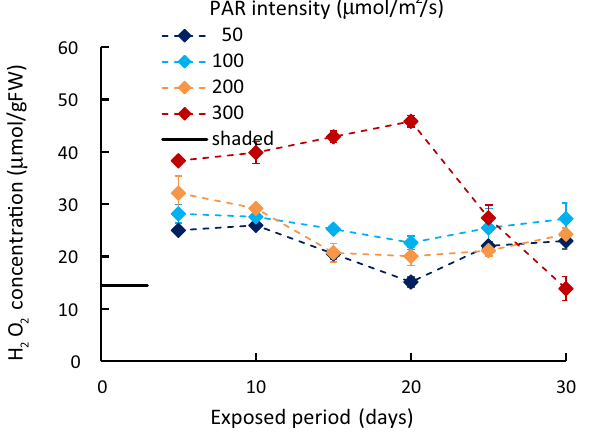
Figure 3. The variation of H 2 O 2 concentration at 1:00 p.m. exposed to different PAR intensities. Vertical bars indicate the standard deviation.